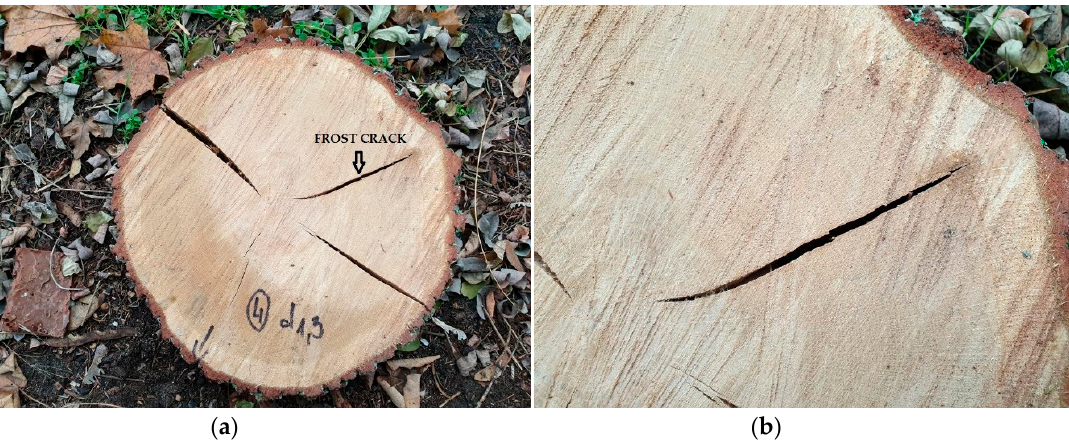
Figure 4. Sample tree number 1; DBH cross-section with frost crack: ( a ) example of a disc with one frost damage; ( b ) no discoloration and decay.